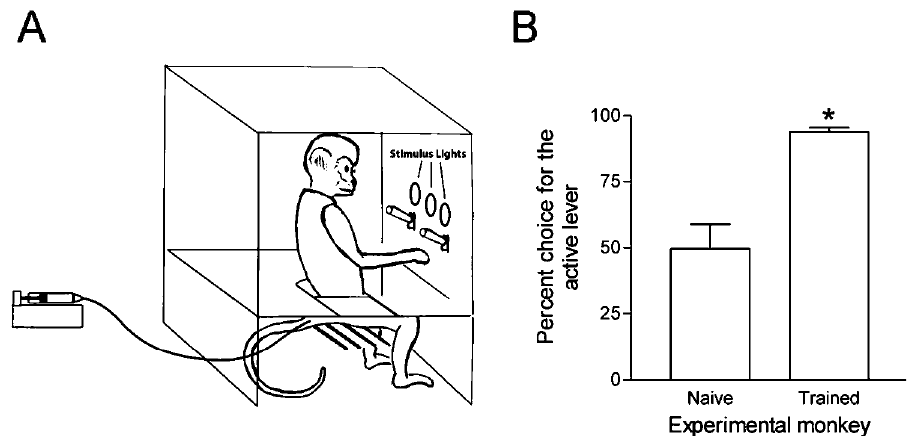
Figure 1. A. Monkeys sat in chambers equipped with two levers and distinctly colored light stimuli above the levers. Completion of the response requirement (the ratio) on the active lever produced a brief two-sec presentation of a light stimulus and an intravenous injection of nicotine followed by a timeout (TO) period of 5 to 60 sec. Completion of the ratio requirement on the inactive lever resulted in presentation of a brief two-sec light stimulus of a different color but no injection. The fixed-ratio (FR) response requirement was gradually increased over successive sessions from one to ten (FR 1 to FR 10). B. Mean percentage choice for responding on the active lever by monkeys when they were experimentally naive (first week under a FR 1 schedule) and when they had learned to self-administer nicotine under the FR 10, TO 60 sec schedule (first week under the FR 10 schedule).